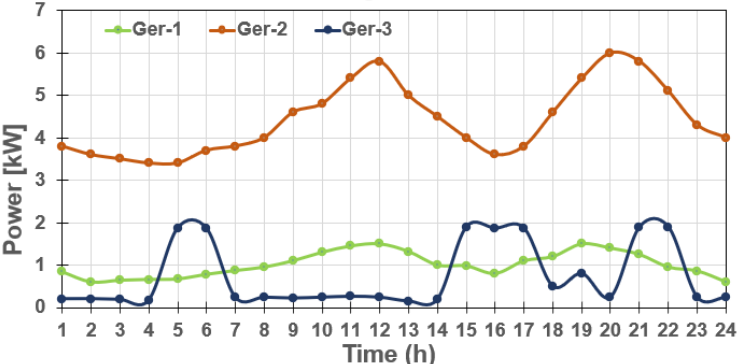
Figure 2. Daily load curves of Mongolian